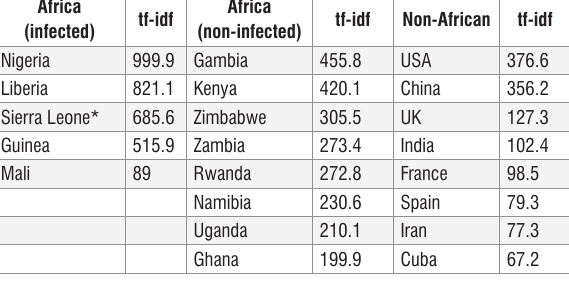
tf-idf, term frequency-inverse document frequency *Some missing data. See supplementary material for more details.